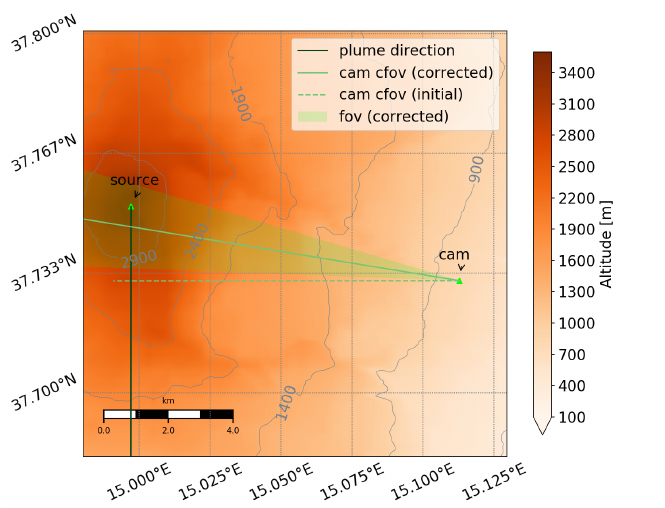
Figure 3. Measurement geometry 2D overview map of the measurement setup at Mt. Etna from the Pyplis example data. The map includes plume orientation (dark green line), camera azimuth retrieved using a compass (dashed light green line), the corrected camera azimuth (light green line) and the corresponding FOV (semi-transparent green), retrieved automatically using the pixel-position i , j of the Etna south-east crater within the images and the corresponding coordinates of the crater (longitude, latitude, altitude). The map was generated using an instance of the MeasGeometry class (see Section